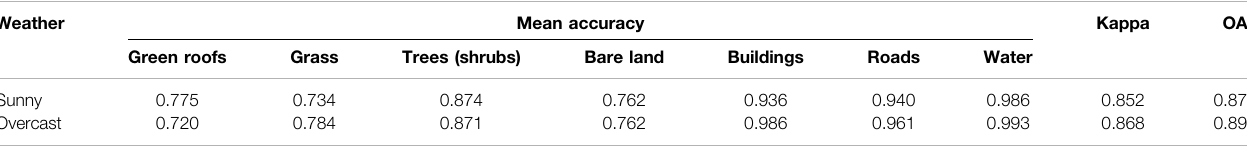
TABLE 4 | Comparison of classi fi cation accuracy under different weather conditions.